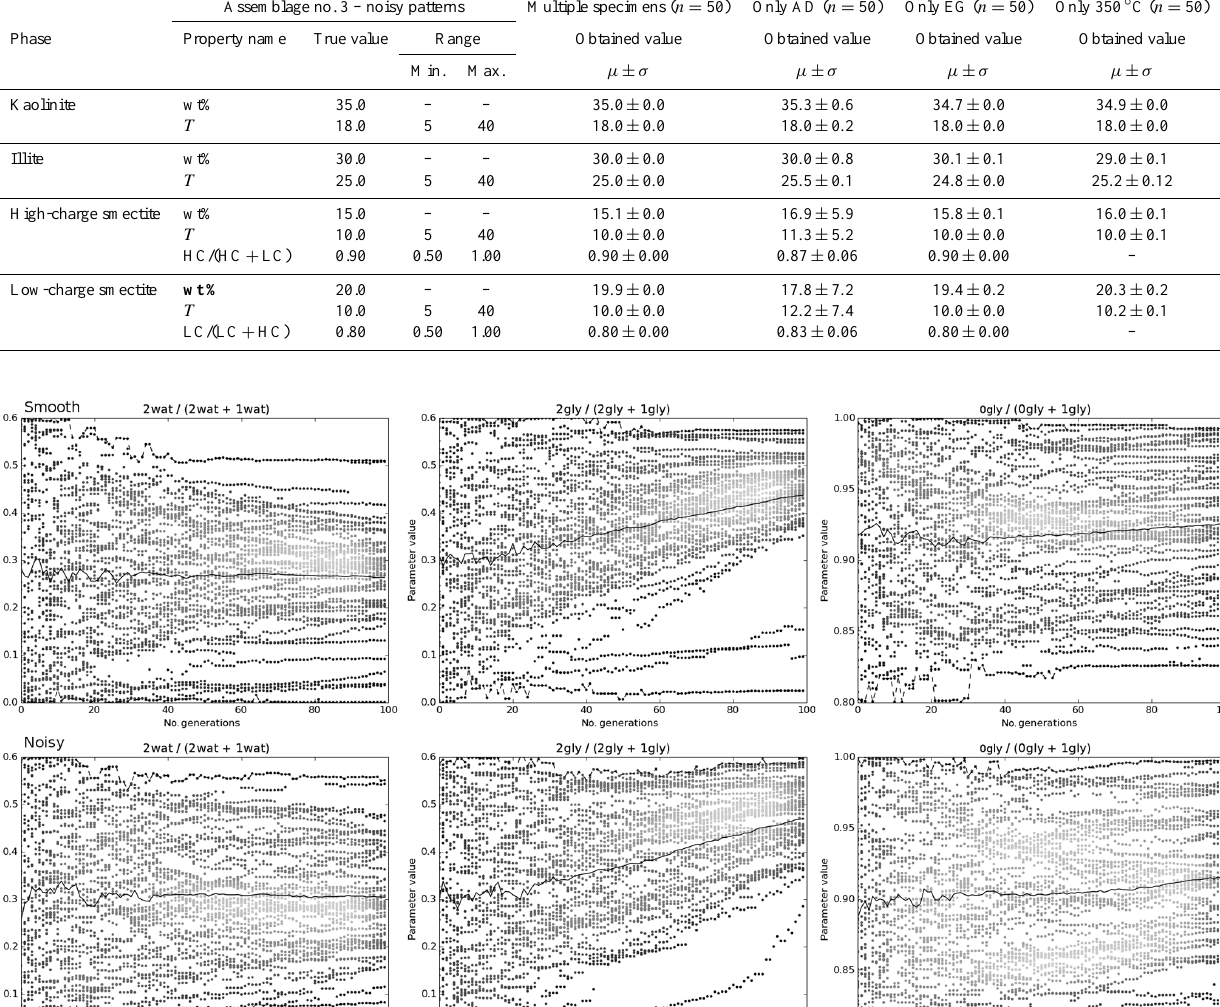
Table 9. Overview of the means and standard deviations of weight fractions and refined parameters for assemblage 3. Assemblage no. 3 – noisy patterns